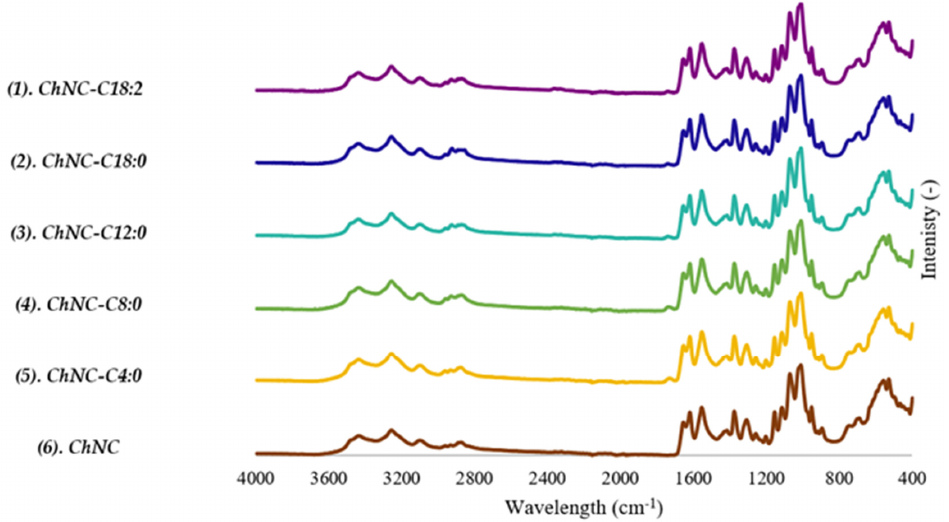
Figure A2. FTIR spectra of (1) ChNC-C18:2, (2) ChNC-18:0, (3) ChNC-C12:0, (4) ChNC-C8:0, (5) ChNC-C4:0, and (6) unmodified.